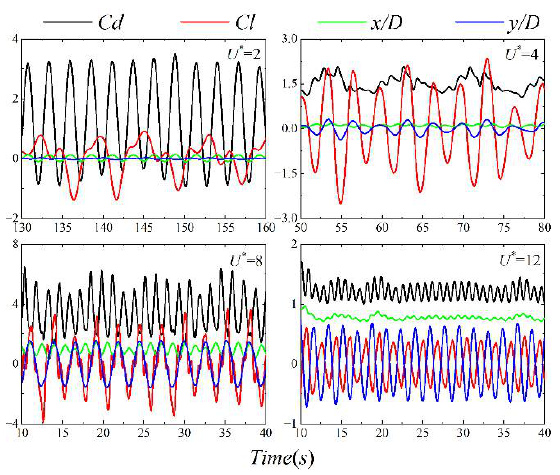
Figure 9. Time history of the force coefficients and displacement for smooth cylinder.